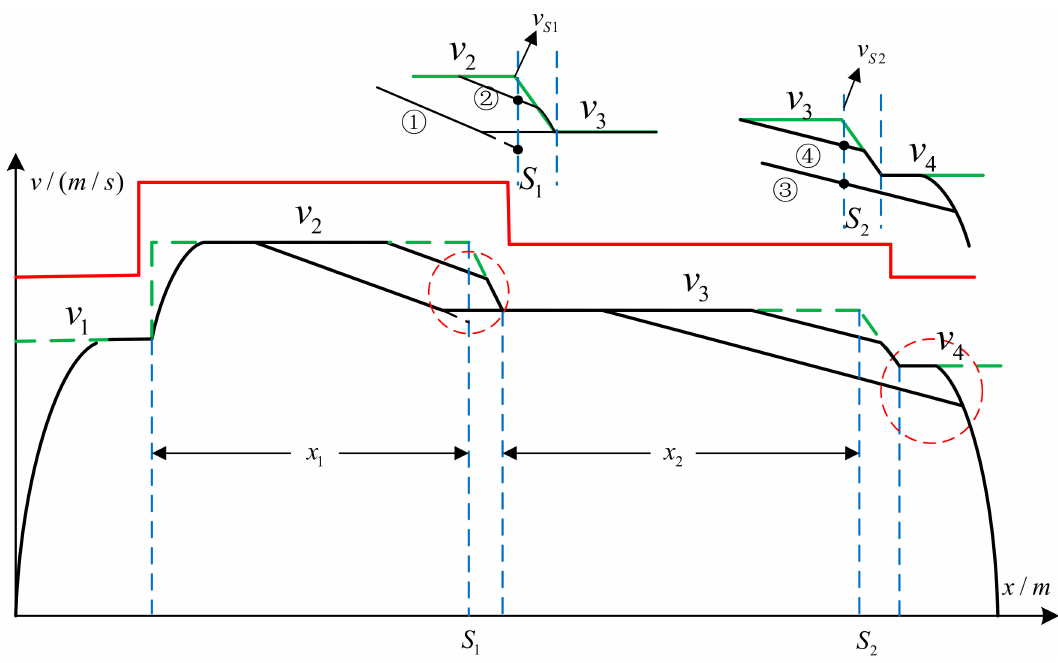
Figure 10. Coast